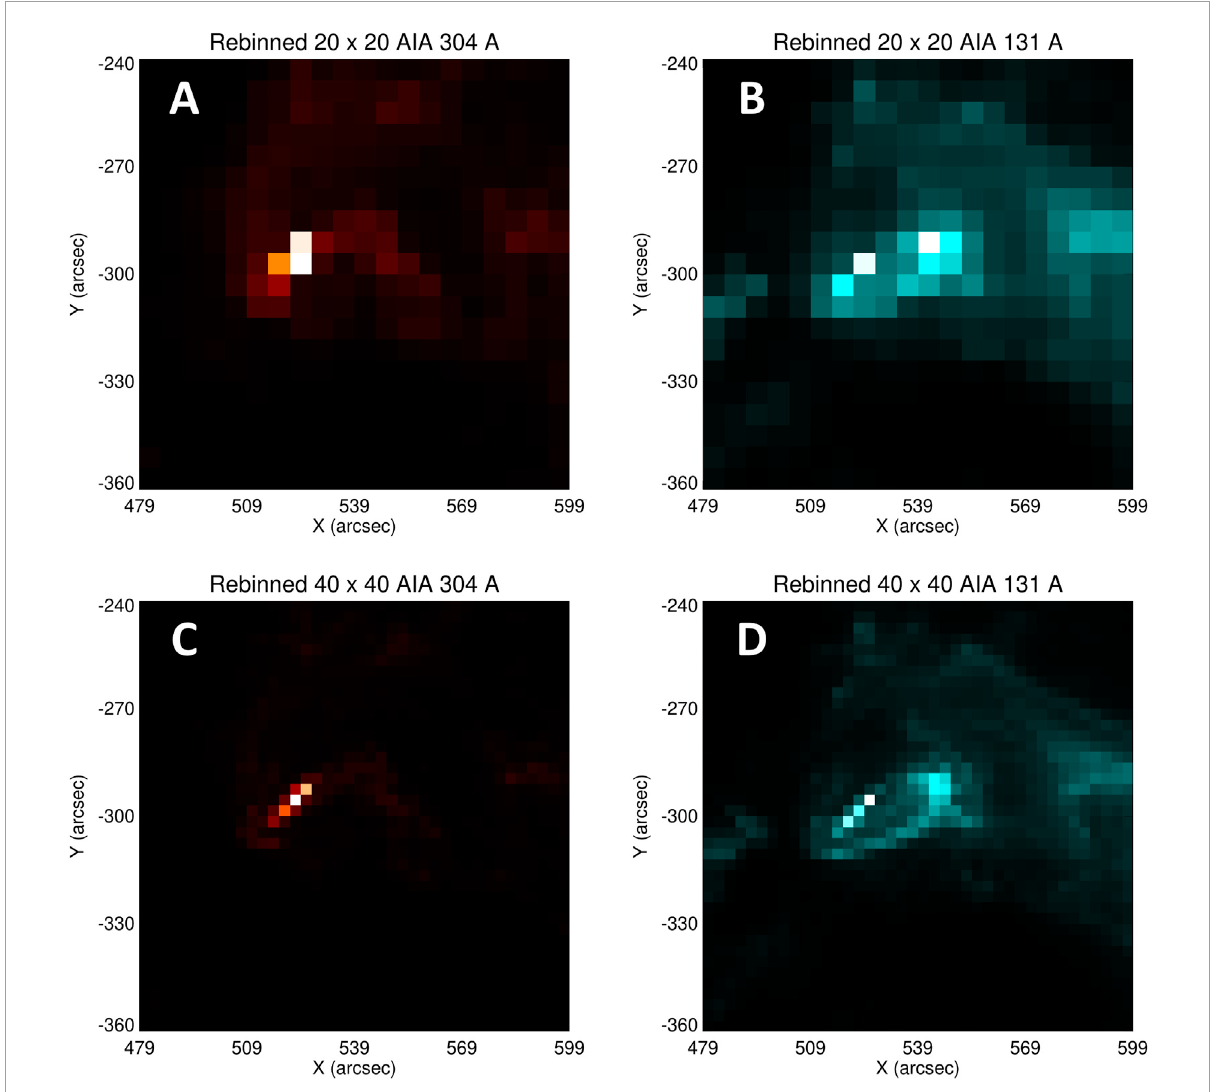
FIGURE 2 The images of Figure 1 , binned into “blocks” measuring 10-pixels by 10-pixels (panels (A) and (B) and 5-pixels by 5-pixels (panels (C) and (D) ). Panels (A) and (B) each contain 20 × 20 = 400 data points, while panels (C) and (D) each contain 40 × 40 = 1 , 600 data points. Note the significantly degraded information content in these images compared to the 40,000-data-point images of Figure 1 .